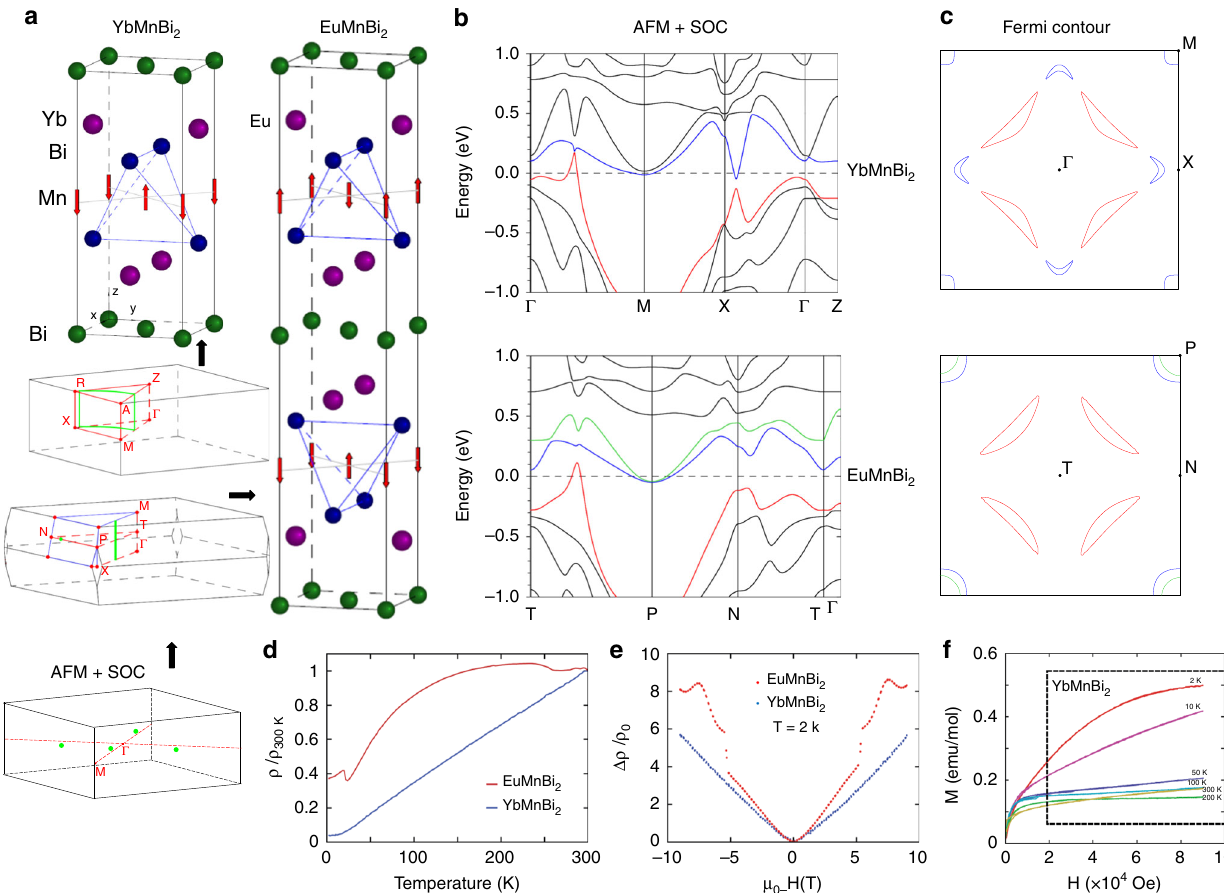
Fig. 1 Calculated electronic structure and basic properties of EuMnBi 2 and YbMnBi 2 . a Crystal structures of both materials together with the corresponding Brillouin Zones. Green lines and a point are a locus of Dirac crossings according to the calculations not taking into account spin – orbit interaction (Supplementary Figs 1 – 4). Red arrows are magnetic moments of Mn atoms. Inset shows the locations of 3D-Dirac points found in the AFM-SOC calculations. b Results of the fully relativistic band-structure calculations taking into account perfectly antiferromagnetic arrangement of Mn moments. c Corresponding Fermi contours for Γ XM and TNP high symmetry planes. d Resistivities and e Magnetoresistances of EuMnBi 2 and YbMnBi 2 . f Magnetization curves showing the onset of the magnetism which breaks time-reversal symmetry in YbMnBi